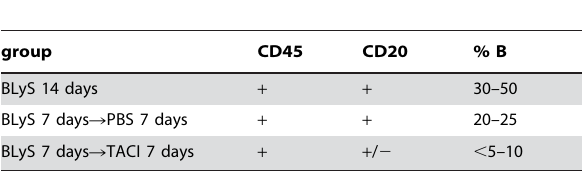
Table 2. BLyS decoy receptor decreases B cell engraftment in NOD rag1 2 / 2 Prf1 2 / 2 mice.